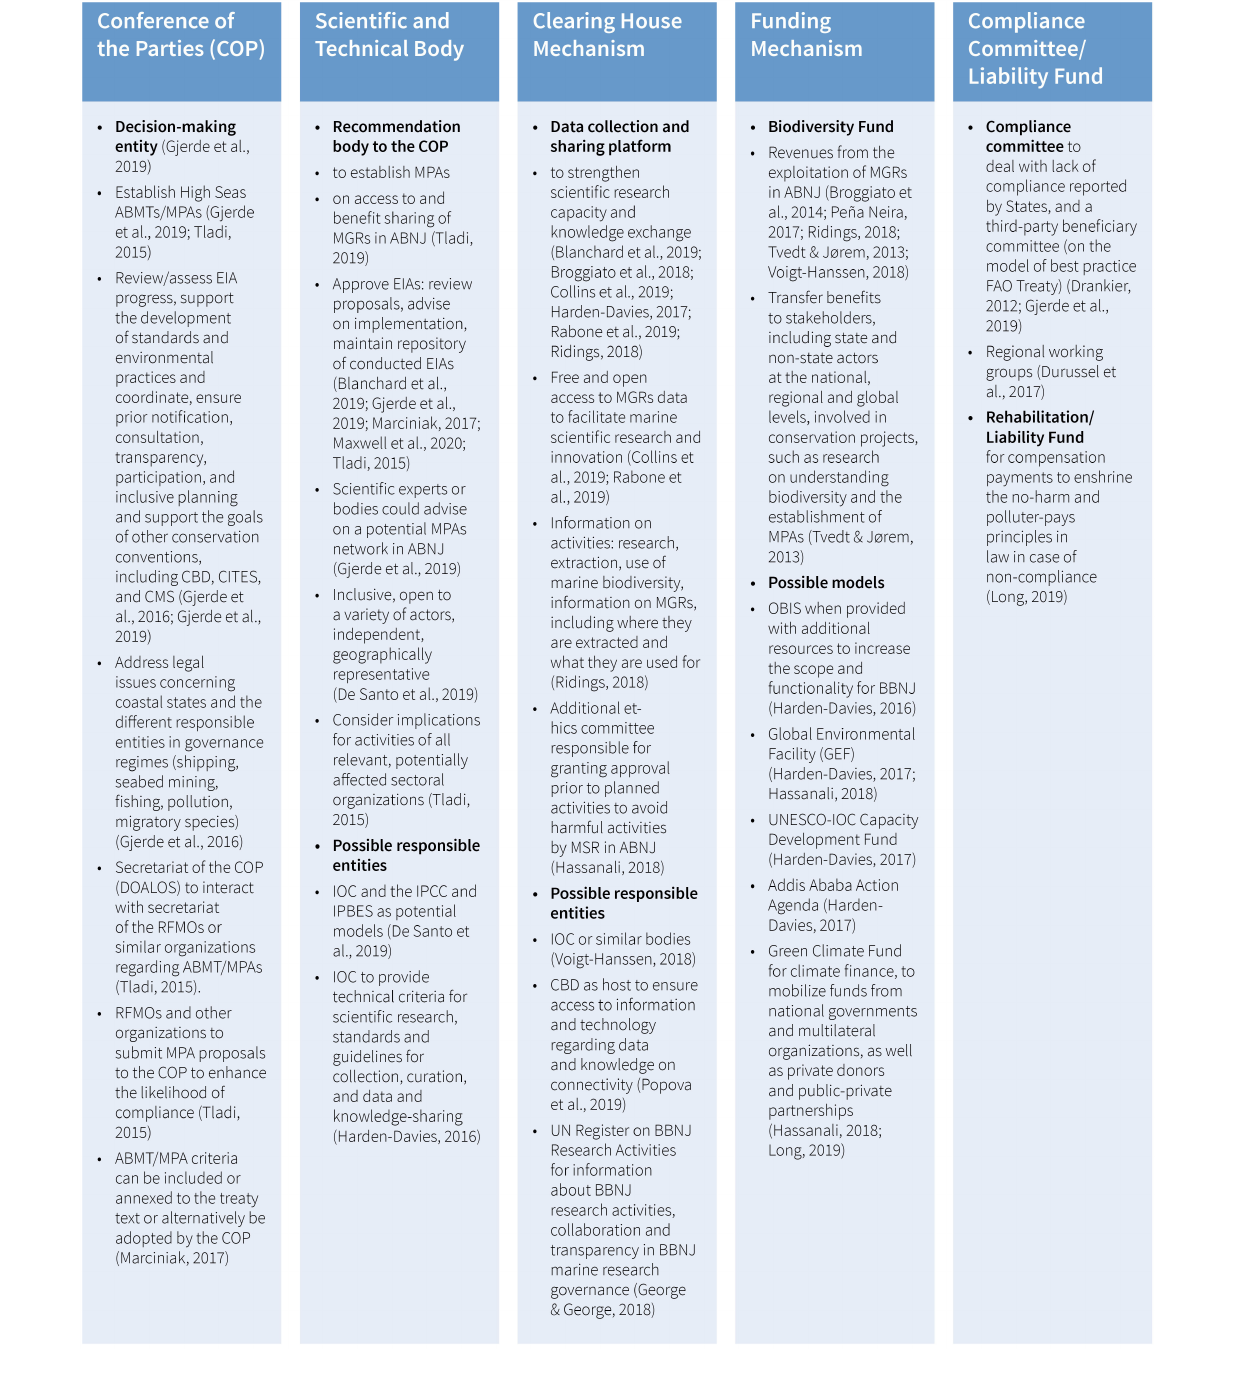
Durussel et al., 2017; Gjerde et al., 2019). It also recommends compensation payments into a rehabilitation or liability fund to enshrine the no-harm and polluter-pays principles in law (Long,